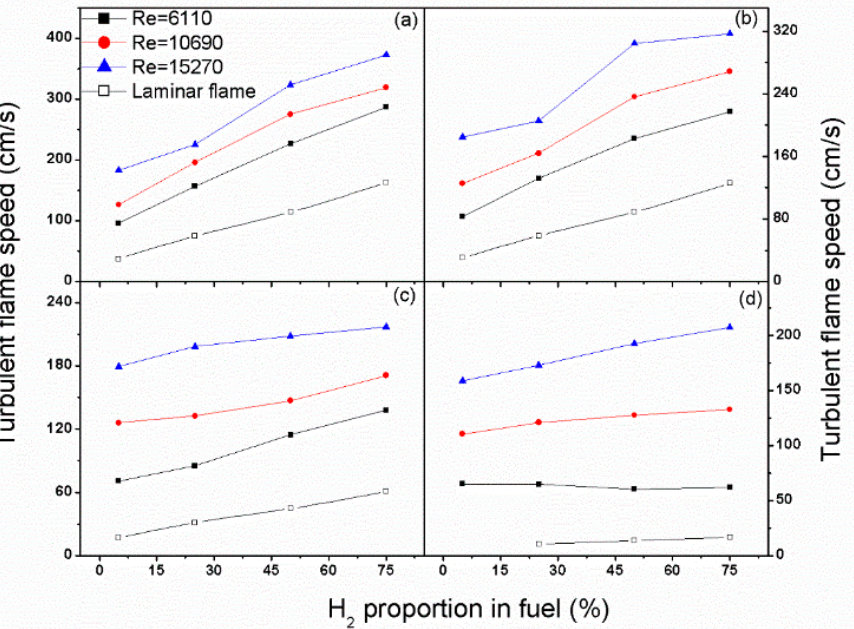
Figure 13. Trend of the turbulent flame velocity of syngas with different nitrogen dilution rates, under different hydrogen proportions in fuel and exit Reynolds numbers: ( a ) 0%; ( b ) 10%; ( c ) 30%; ( d ) 50% nitrogen dilution volumetric rate.